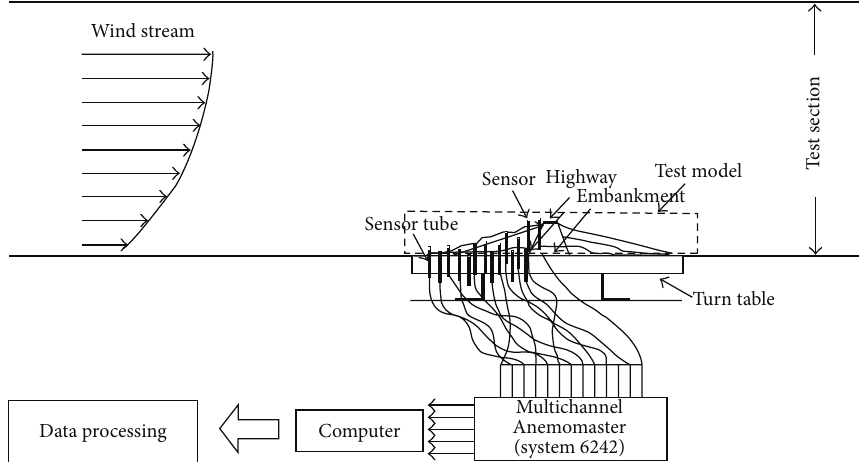
Figure 4: Outline of measurement of wind